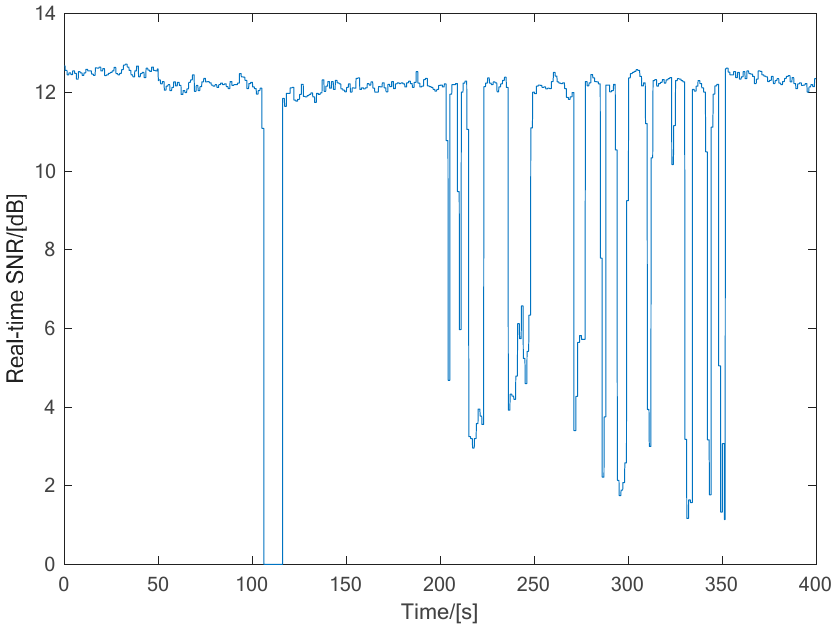
Figure 17. Real-time SNR of SOTM of the conventional method.